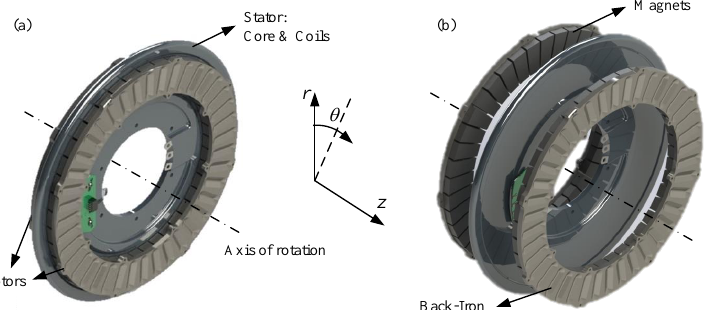
Figure 1. ( a ) Example of an AFPM machine with an internal stator and two external rotors. ( b ) Ex- ploded